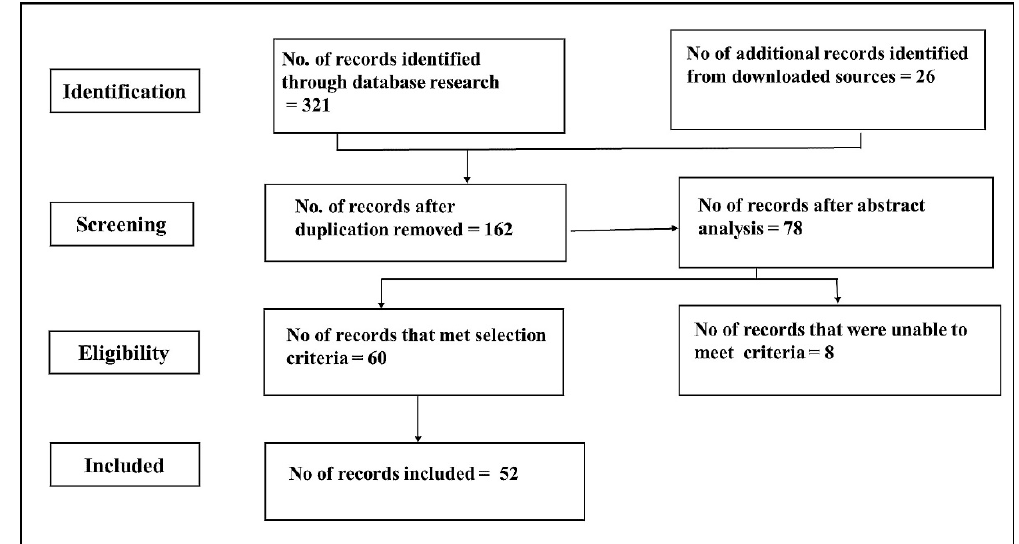
Figure 3. A flow diagram of PRISMA [41] .